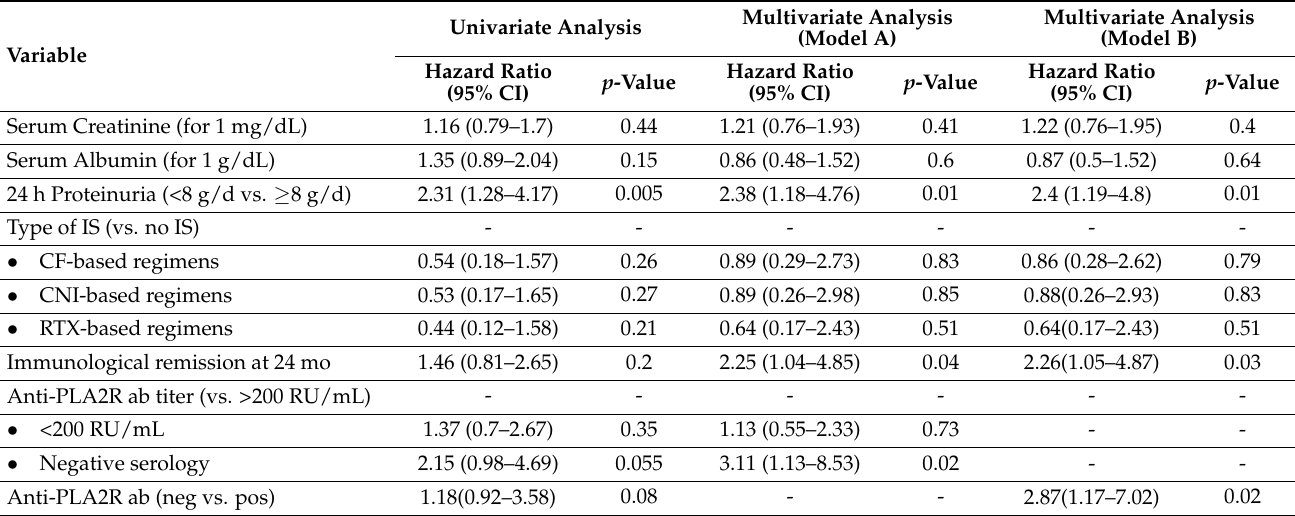
Table 3. Univariate and multivariate Cox proportional hazard regression analysis regarding predictor of treatment response (partial or complete